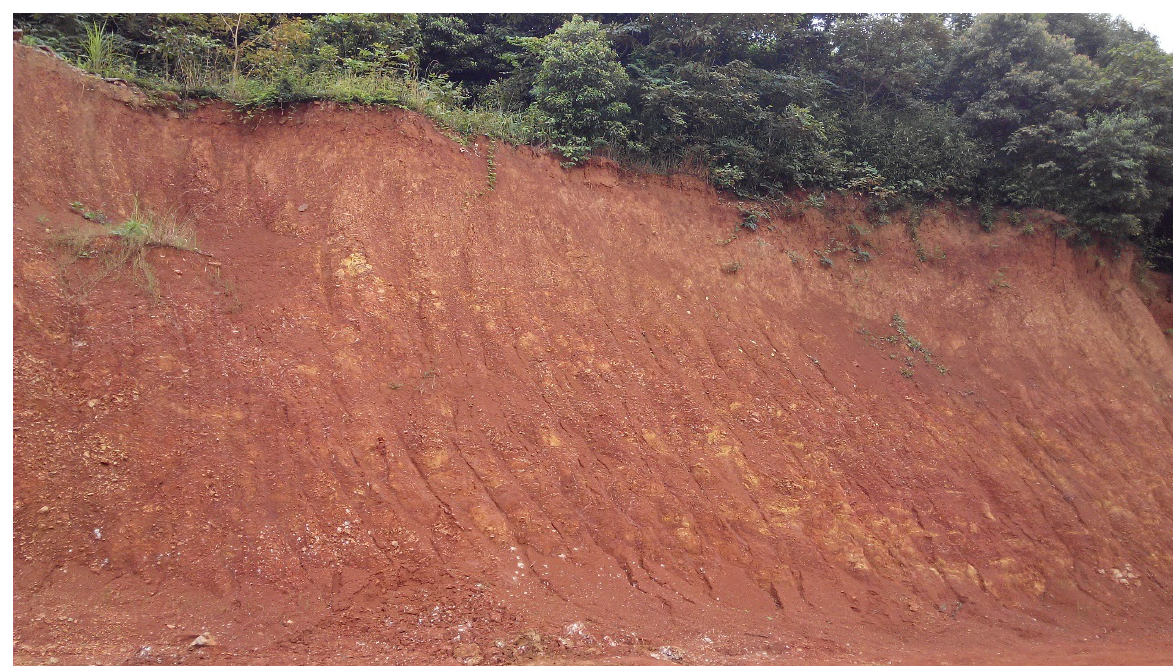
Figure 1. The sampling area in Shewushan gold deposit.